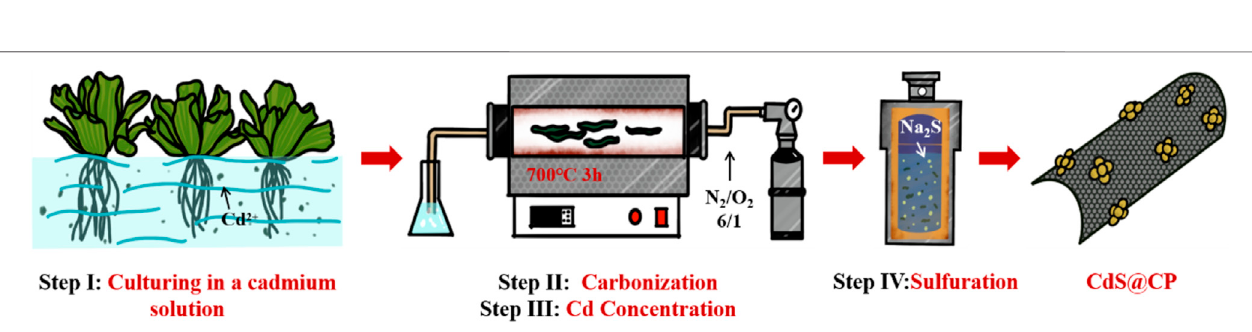
Frontiers in Chemistry |